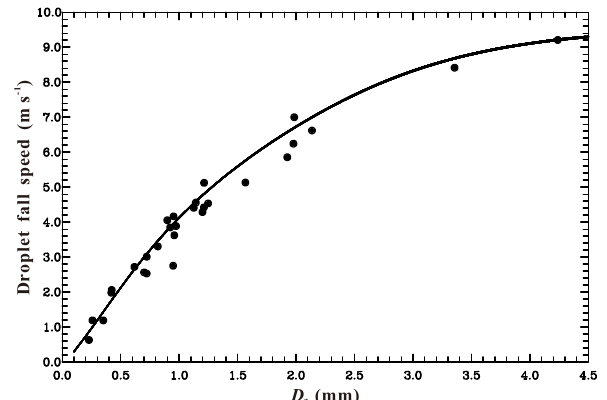
Figure 10. As in Fig. 6 but showing 29 analyzed drops collected from the outdoor experiments.